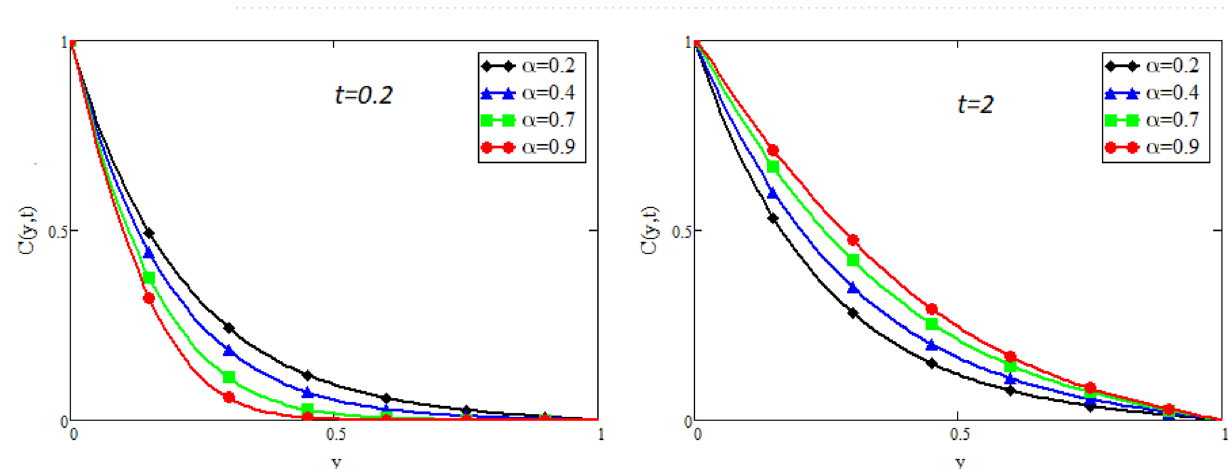
Figure 11. Impact of α on concentration distribution when Sc = 20 .